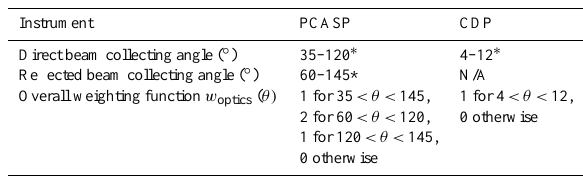
Table 1. Collecting angles of the PCASP and CDP optics and asso- ciated values of w optics ( θ)